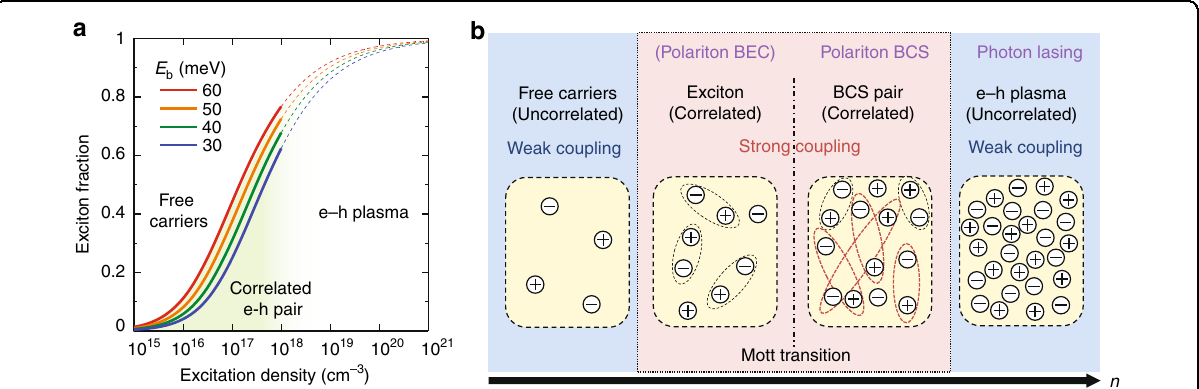
Fig. 1 Excited states expected for CsPbBr 3 microcavity at RT. a Exciton fraction x/n as a function of total excitation density n calculated from Saha relationship (Eq. (S1.1) in Supplementary Information). b A schematic revealing transitions of populated excitation particles and coupling regimes varied with increased excitation